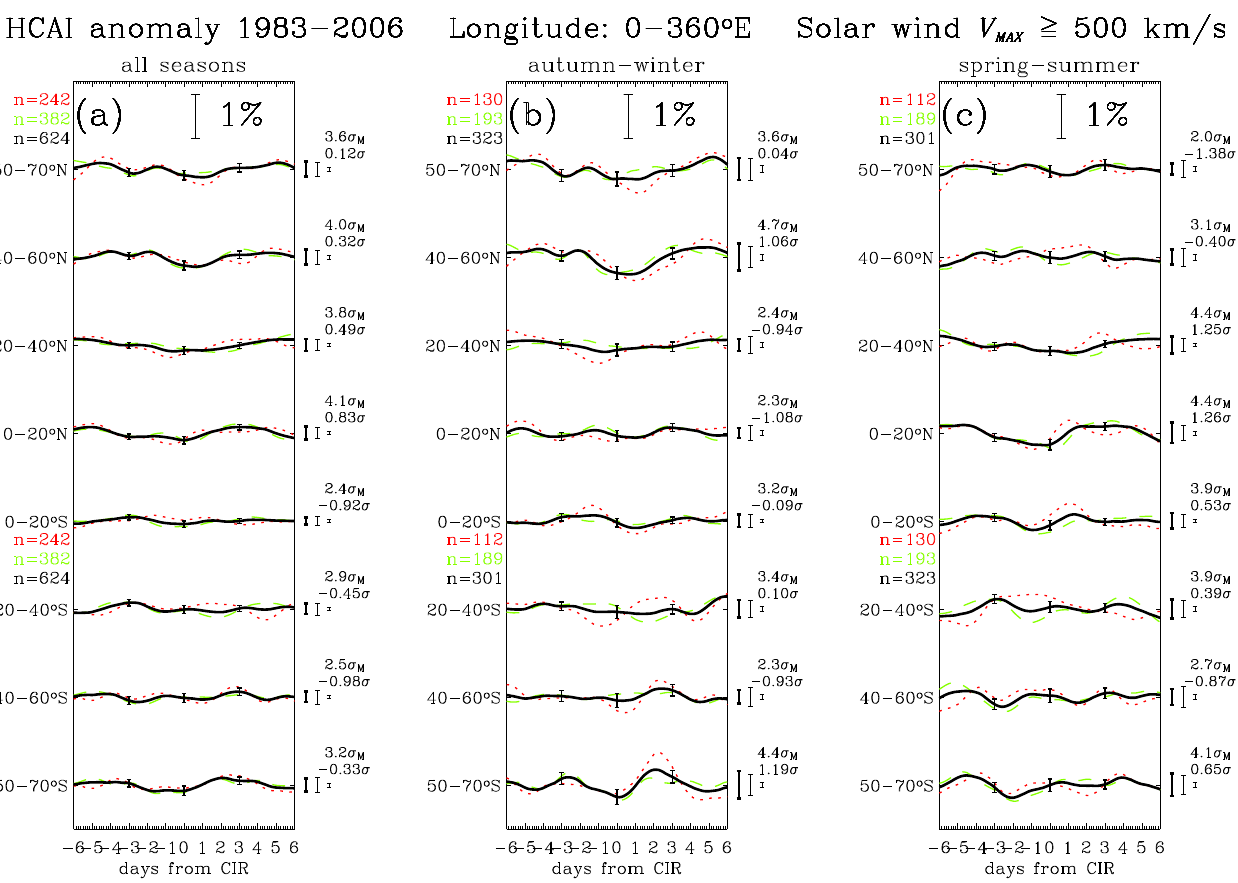
Fig. 12. The SPE analysis of high cloud area index (HCAI) for 20 ◦ -wide latitude bands for the Northern and Southern Hemispheres. The key times are the arrivals of solar wind streams with maximum velocity V MAX ≥ 500km/s for (a) all seasons, (b) autumn-winter and (c) spring- summer. The HCAI anomaly for the whole time interval 1983—2006 (black line) and two sub-intervals consisting of years of high (dotted red line) and low (dashed green line) volcanic aerosol loading is shown. The bold bars on the right are the observed amplitudes over the 12-day period. The light bars are the mean amplitudes and standard deviation σ of the mean for 100 sets of random key times representing the mean statistical noise. Departures 1 of the observed amplitude from the estimated statistical noise level in terms of σ are shown. Representative error bars shown on each curve are two standard errors of the mean σ M